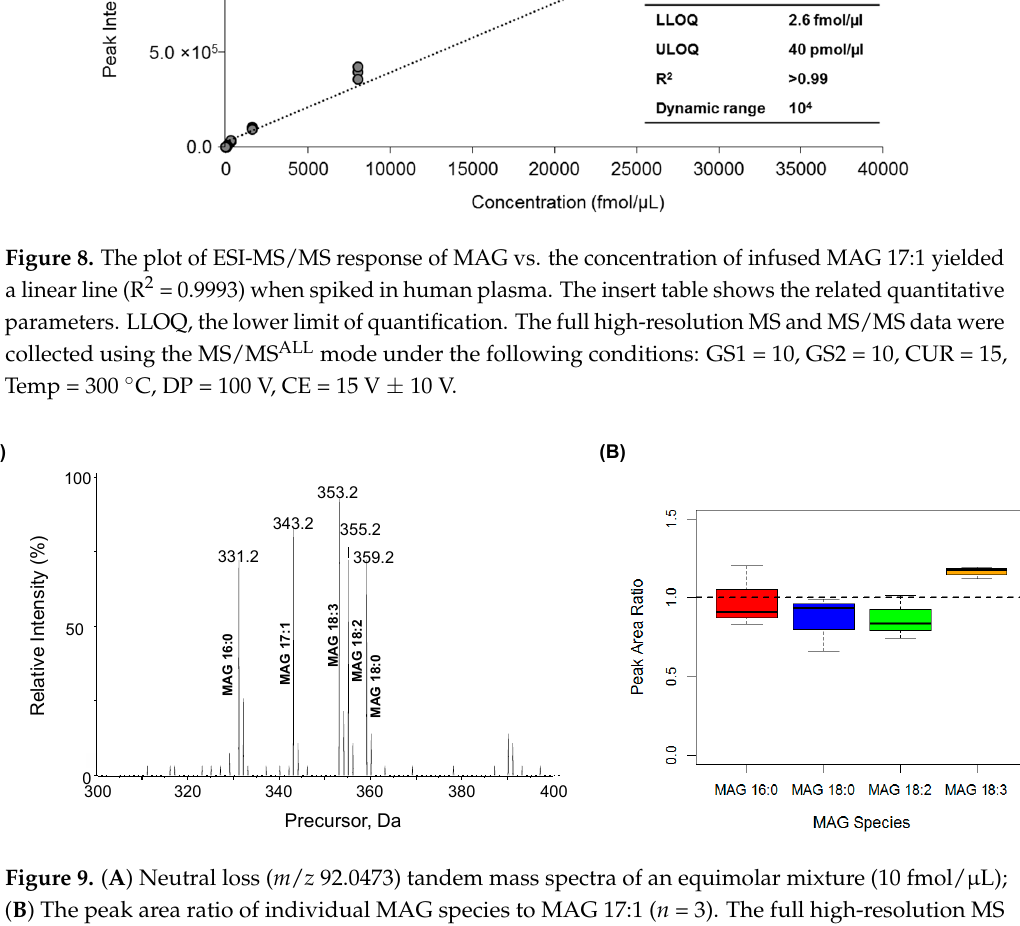
Table 1. Reproducibility of the MS/MS ALL technique for MAG.